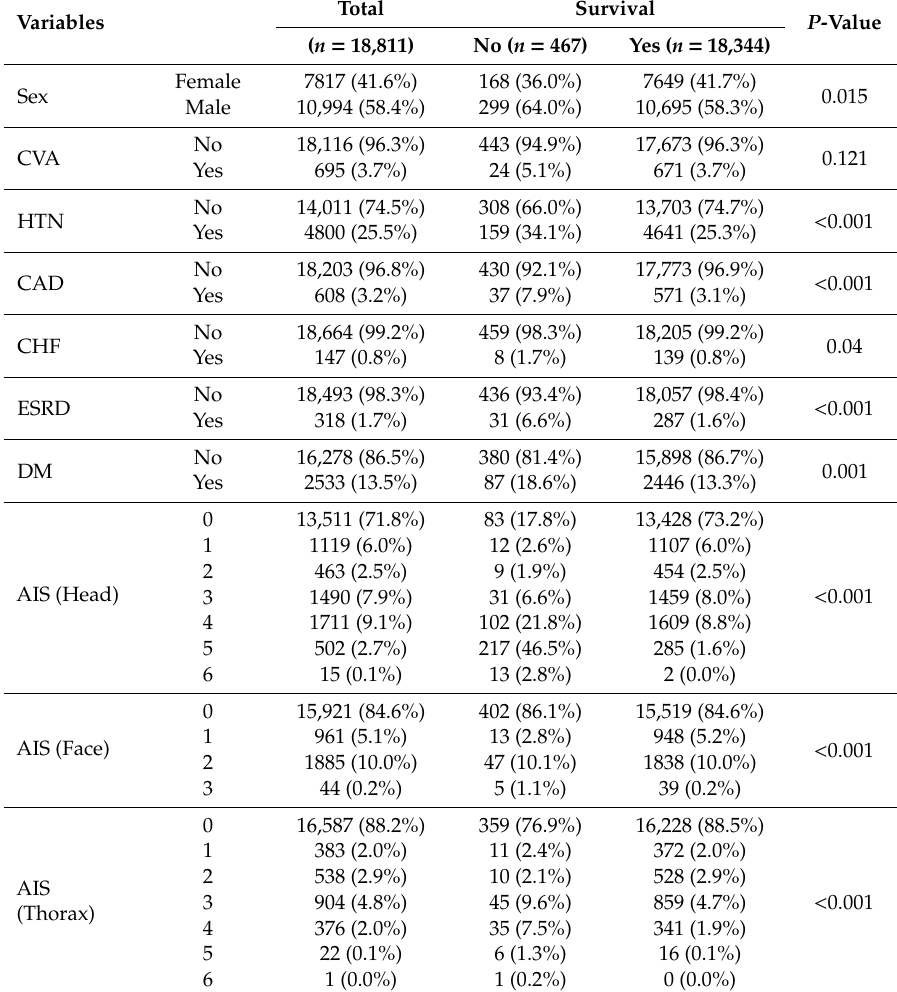
Table 2. Categorical variables of patient characteristics of those trauma patients who survived or